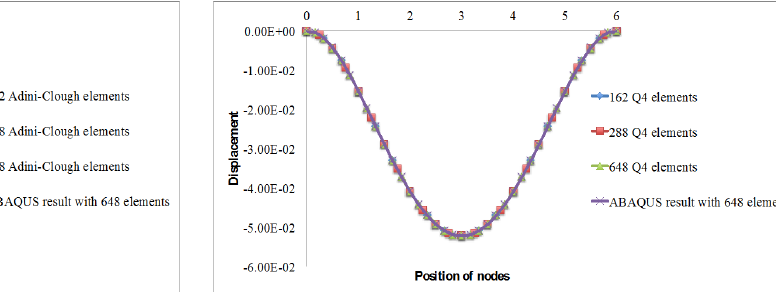
Figure 9: Transverse displacement u 3 along the long edge for a single-layer shell with Q4 elements.